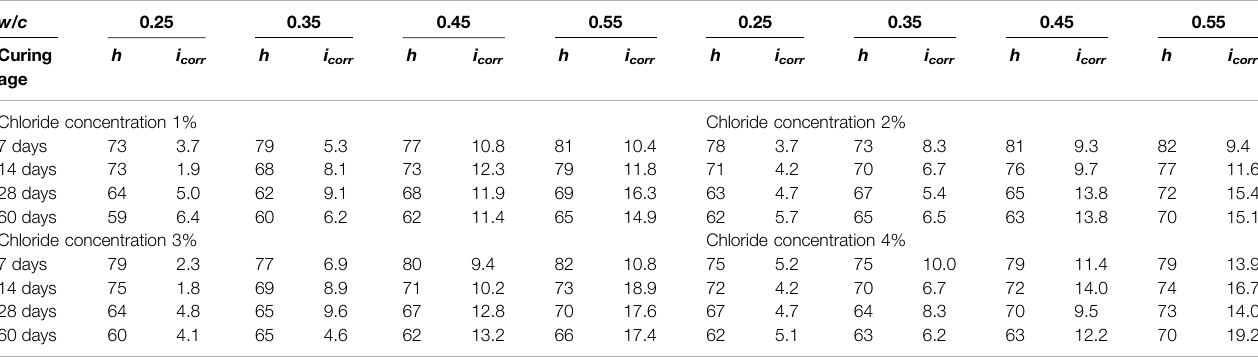
TABLE 2 | Measured relative humidity (%) and corrosion current density (10 − 3 A/m 2 ).